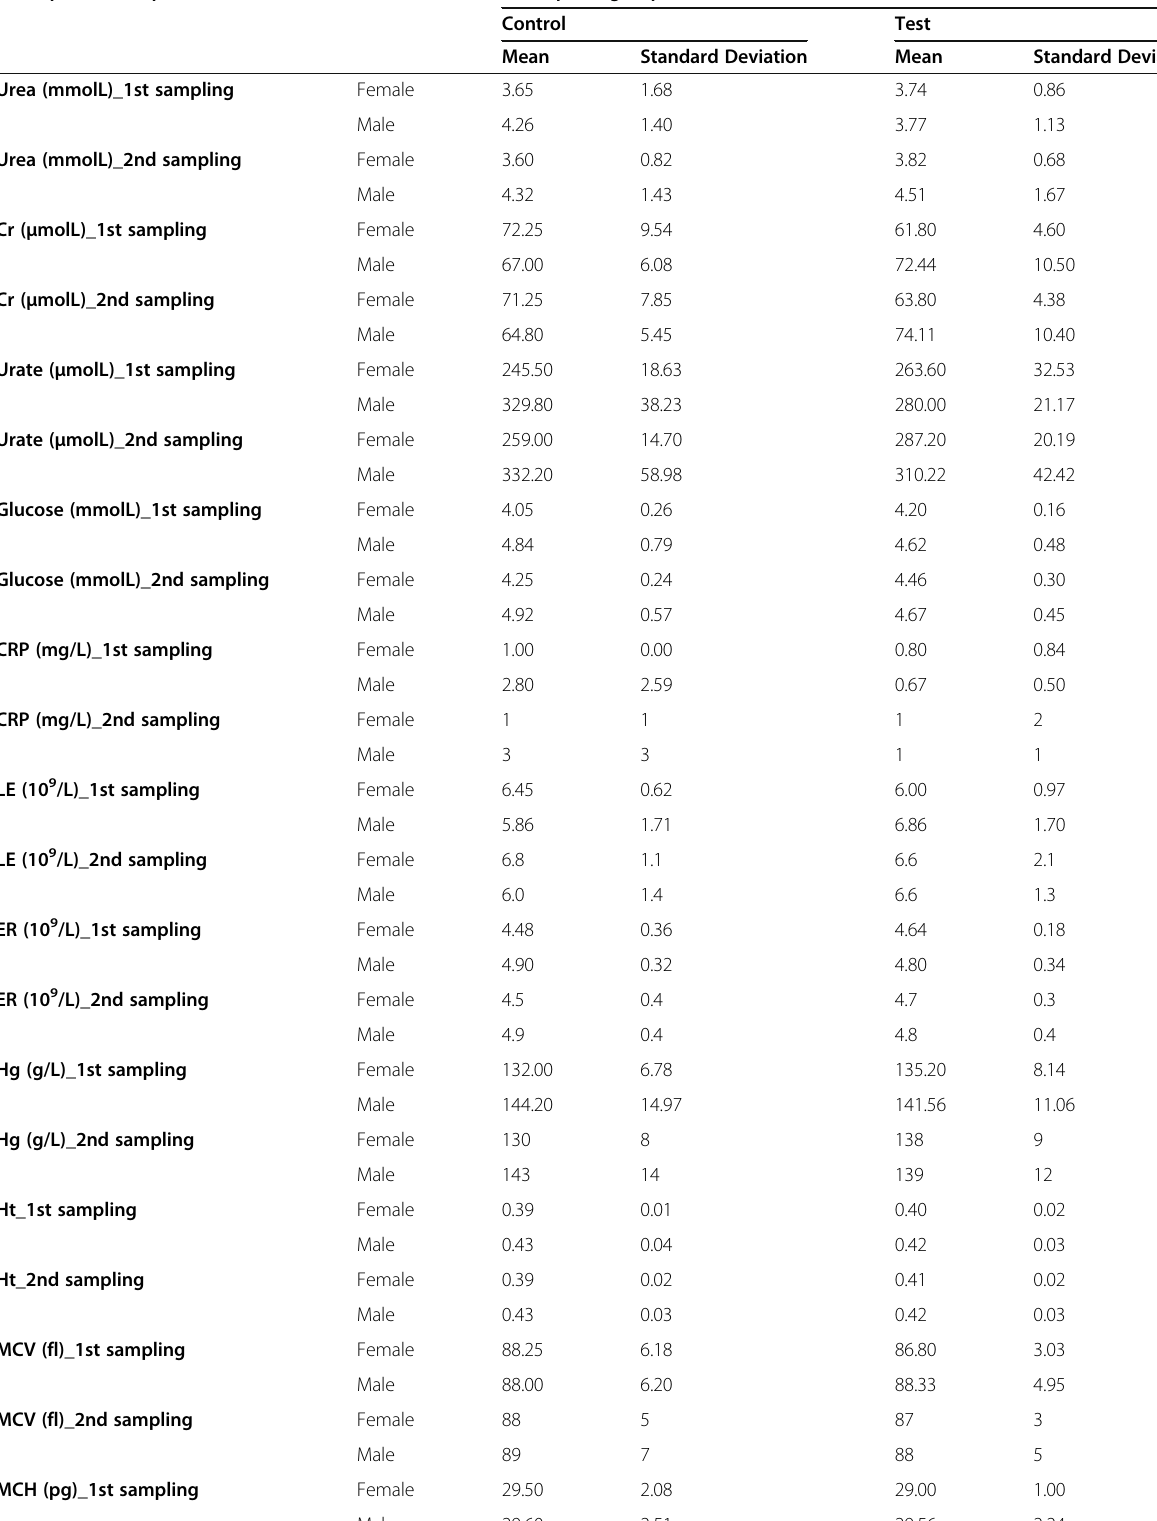
Table 2 Blood parameter value during 1st and 2nd sampling Participant blood parameter Participants